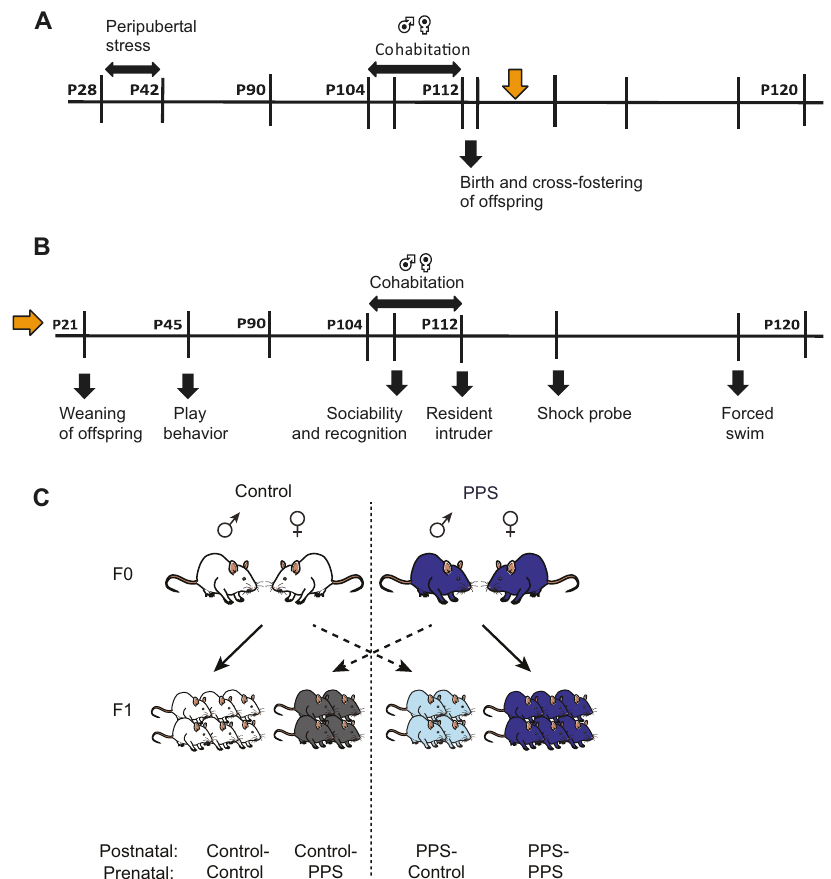
Fig. 1 Schematic of the experimental procedure and cross-fostering of pups. A Timeline of experimental procedure on F0 generation males and cross-fostering of pups. Orange arrow, start of behavioral experiments on F1 generation. See Supplementary fi gure 1 for a detailed description of the behavioral tests performed on F0 males. B Experimental timeline of behavioral tests performed on the F1 males. C For cross- fostering, the pups were divided into four groups — (i) Control – Control - born to and raised by the same dam, paired with a control male, (ii) Control-PPS — born to a dam paired with a PPS male, but fostered with a dam paired with a control male, (iii) PPS-Control — born to a dam paired with a control male, but fostered with a dam paired with a PPS male and (iv) PPS – PPS — born to, and raised by the same dam, paired with a PPS